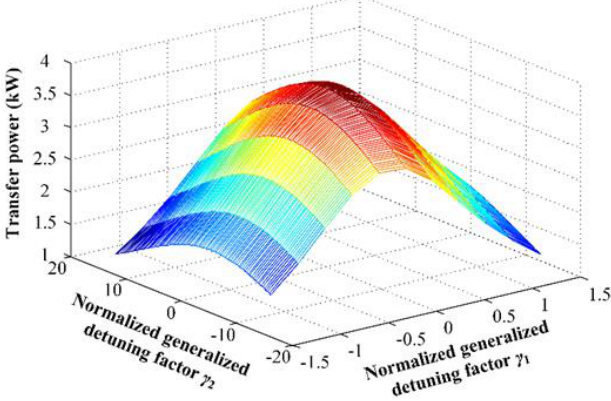
Figure 4. Output power versus detuning factors in 3D space.